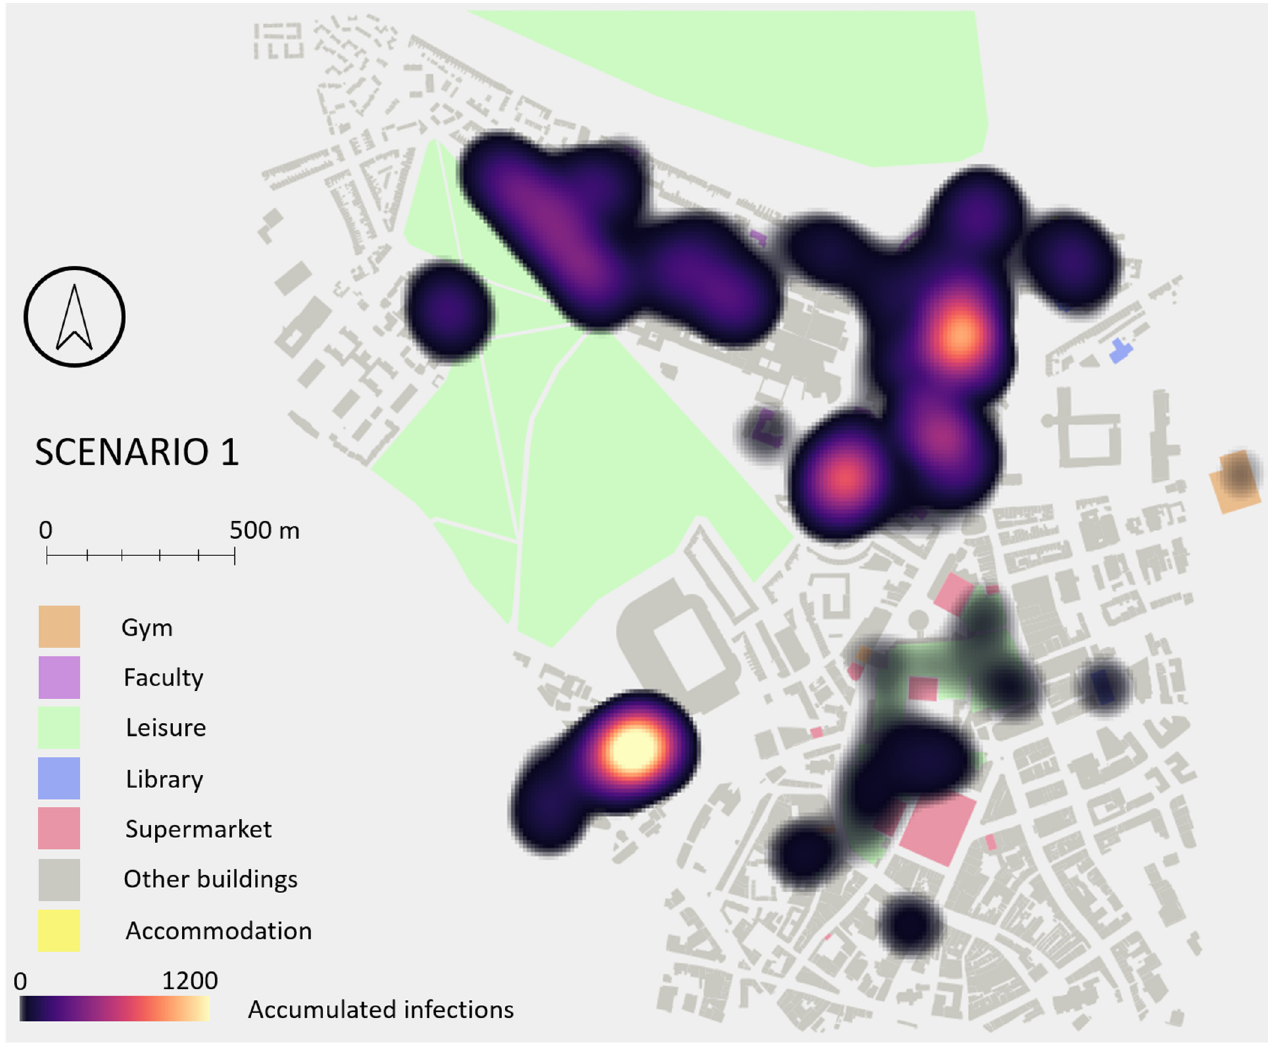
Figure A5. Heat map for Scenario 1 showing the areas (in light yellow) where more infections were produced. Two main hotspots are visible, one in the SE where two student accommodations and a busy supermarket are located, and the other in the main campus where most faculty buildings and another busy supermarket are located. Contains Ordnance Survey data © Crown copyright and database right 2020.